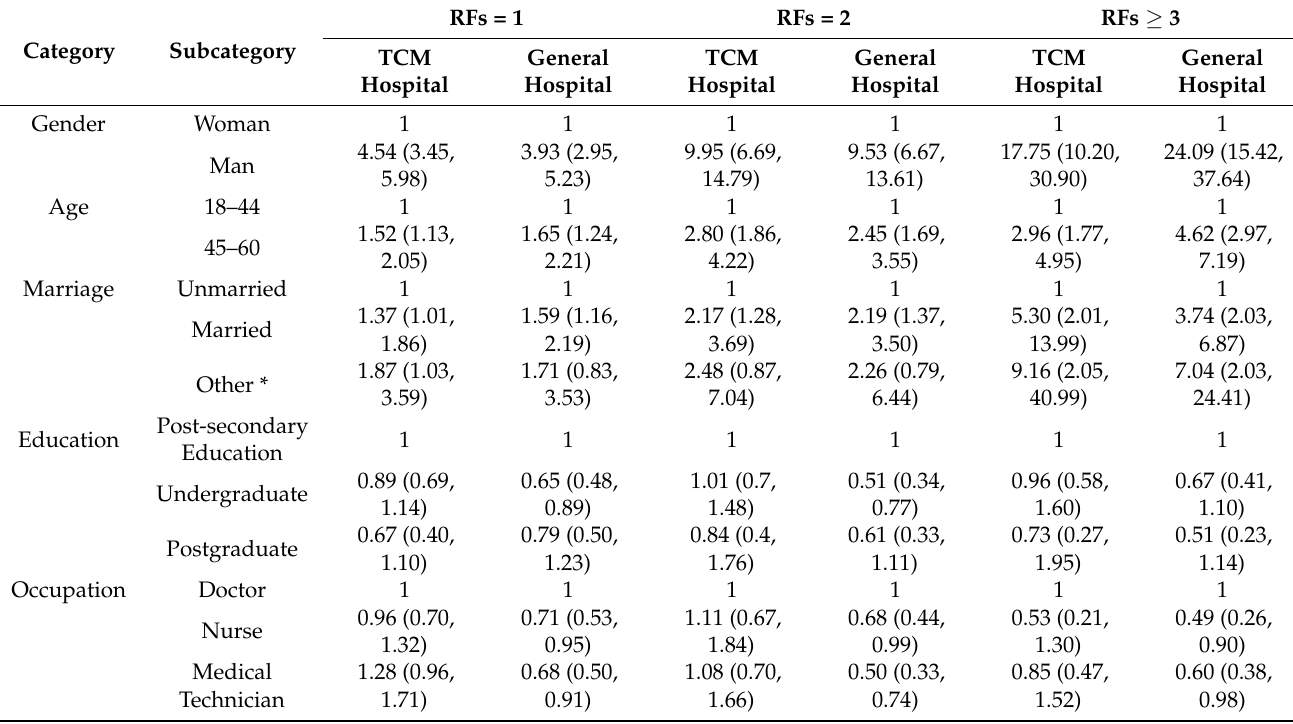
Table 5. The multiple logistic analysis of the CVD risk factor clustering by hospital